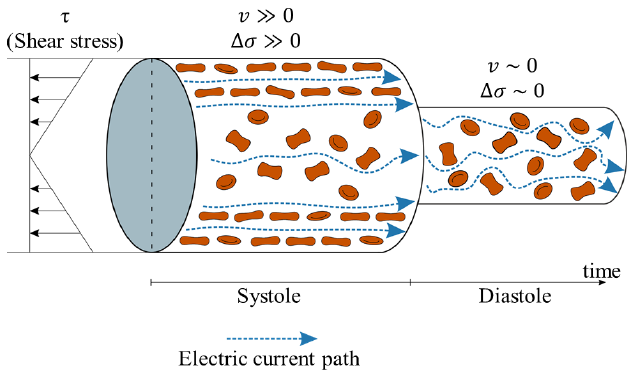
Fig.4: Orientation and deformation of RBCs in a blood vessel during the systole and diastole.